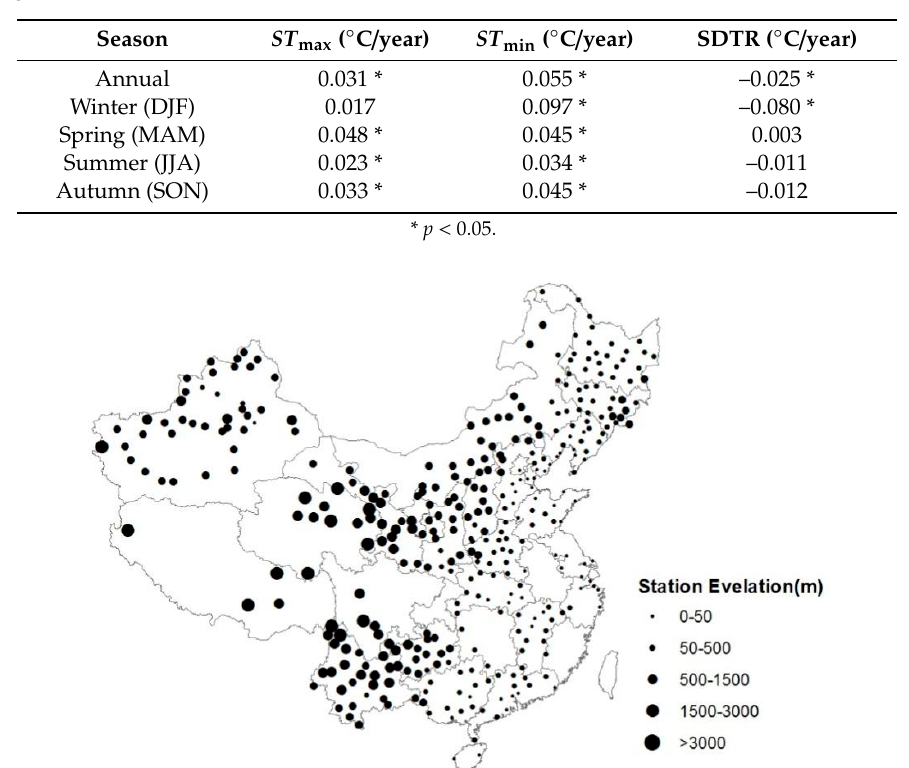
Table 2. National trends of max ST , min ST 1962–2011.